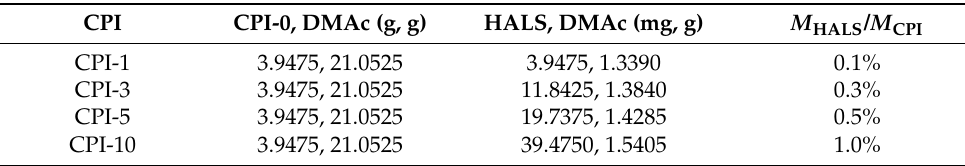
Table 1. Formulas for the preparation of CPI/HALS nanocomposite films. CPI CPI-0, DMAc (g, g)